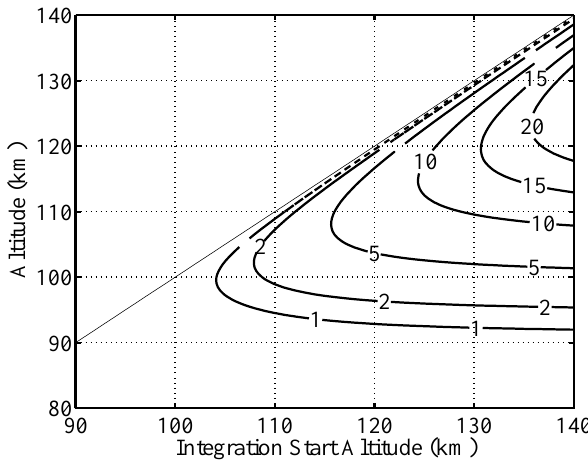
Fig. 4. Similar to Fig. 3 except that the signal correction has been applied to the simulated photon-count